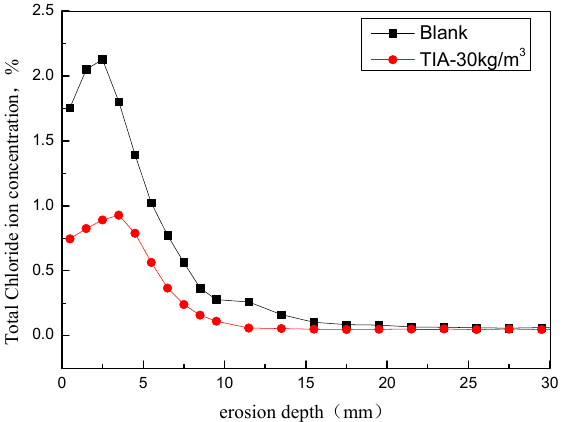
Figure 5. Total chloride ion depth from the concrete side with and without a TIA nano-hydrophobic admixture.